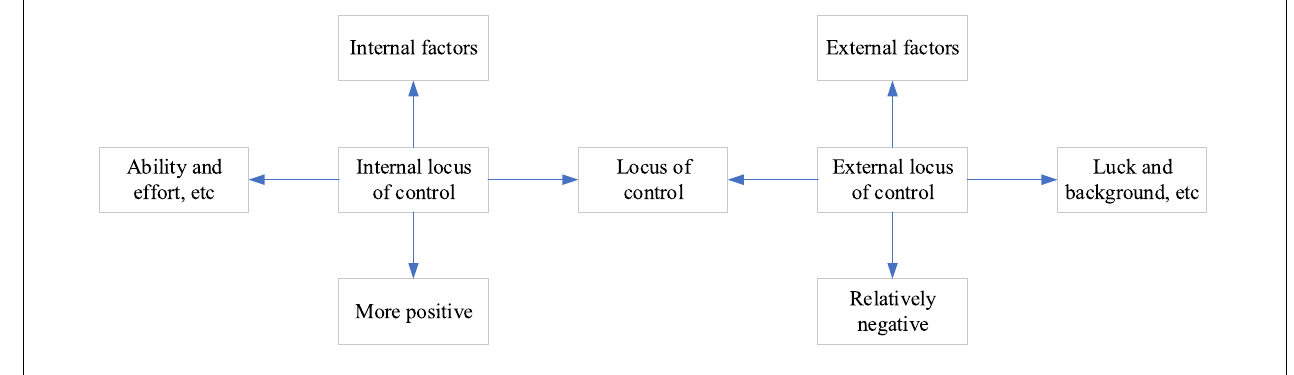
FIGURE 3 | Locus of